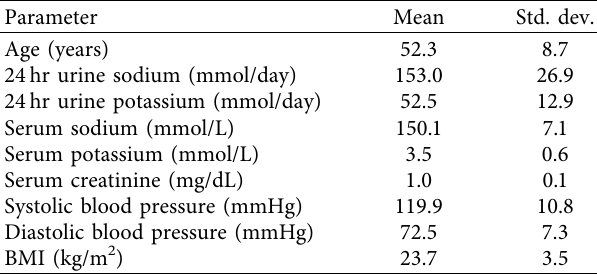
Table 1: Mean values of baseline characteristics. Parameter